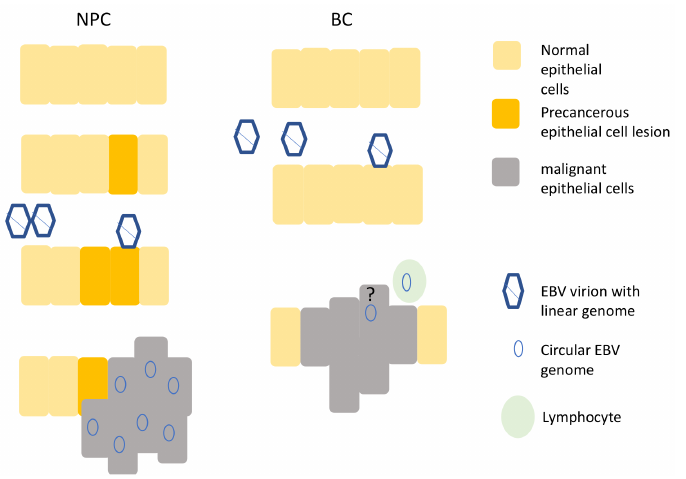
Figure 1. Model of Epstein–Barr virus (EBV) infection contrasting nasopharyngeal carcinoma (NPC) and breast cancer (BC). The question mark indicates the uncertainty in the field about whether the EBV detected in BC biopsies is present in epithelial cells or